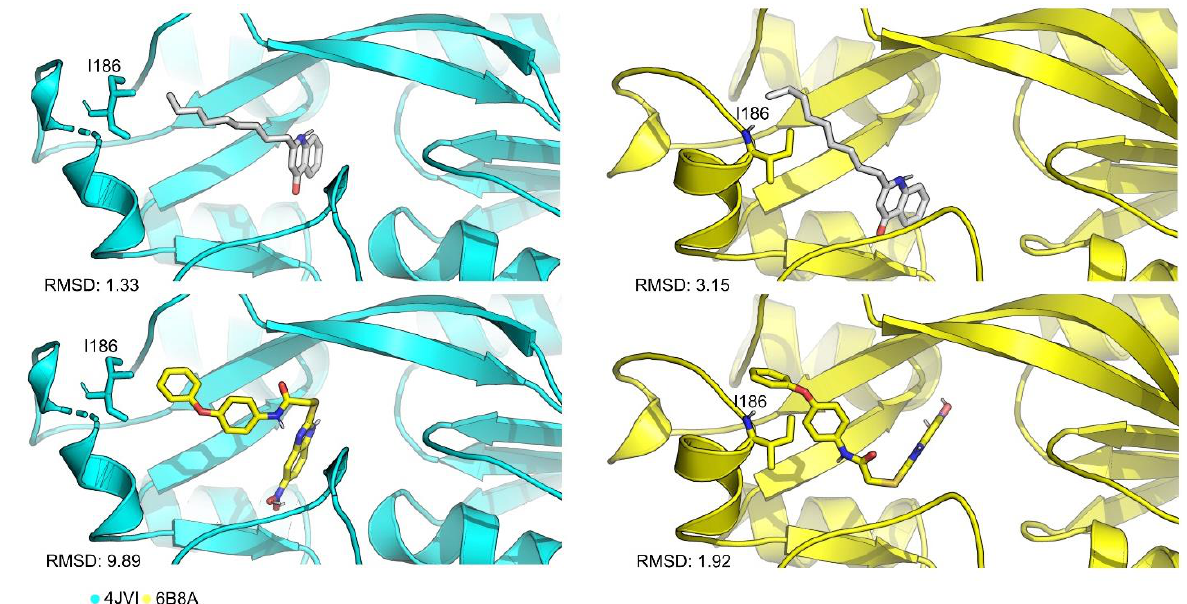
Figure 2. Cartoon representation of the active site residues for 4JVI (cyan), 6B8A (yellow), NNQ ligand (white) and M64 (yellow). The main difference in these three structures is the position of residue Ile186 that in 6B8A structure tends to close the binding site, accommodating bulkier lig- ands.